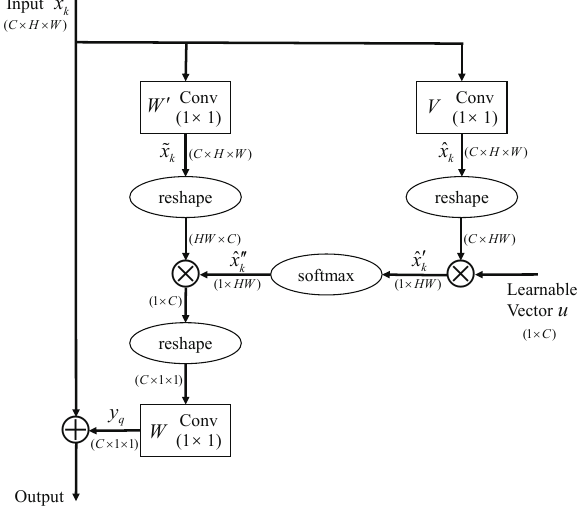
Figure 2. The flowchart of attention weight calculation in the proposed method. The numbers in parentheses denote the shape of the feature